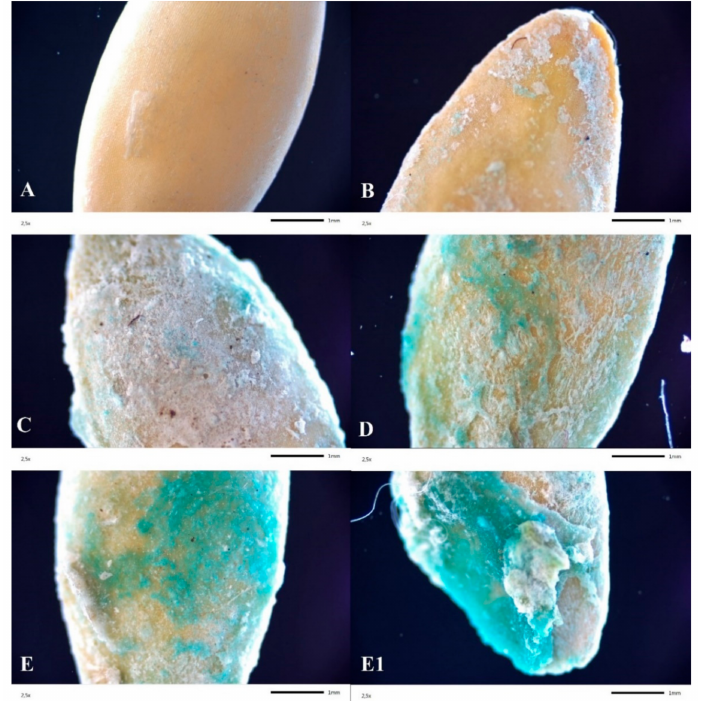
Figure 2. Optical microscope images of S1 ( A ), S5.1 ( B ), S5.2 ( C ), S5.3 ( D ) and S5.4 ( E , E1 ), zoom × 2.5 (S1—Uncoated seeds, S5.1—Seed coating containing a solution of 2% alginate with amino acids (37.6 mL/100 g), micronutrients (37.5 mL/100 g), and NPK, S5.2—Seed coating containing a solution of 2% alginate with amino acids (75.1 mL/100 g), micronutrients (75.1 mL/100 g), and NPK, S5.3—Seed coating containing a solution of 2% alginate with amino acids (112 mL/100 g), micronutrients (112 mL/100 g), and NPK, S5.4—Seed coating containing a solution of 2% alginate with amino acids (150 mL/100 g), micronutrients (150 mL/100 g), and